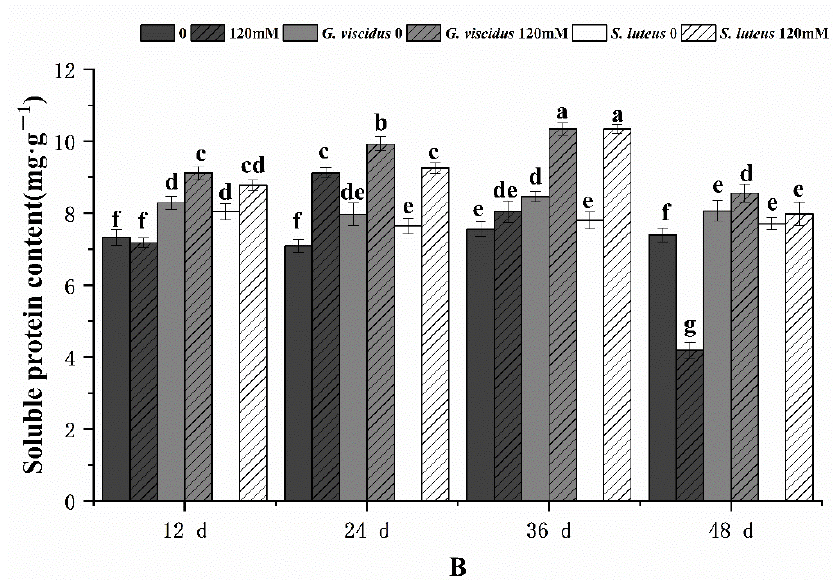
Figure 10. Changes in soluble sugar ( A ), soluble protein ( B ) in ectomycorrhizal seedlings of Q. mongolica under NaCl stress. Bars represent means of five replicates (±SD). For each parameter, bars keyed with different letters indicate significant differences among treatments, p ≤ 0.05, following one-way ANOVA.